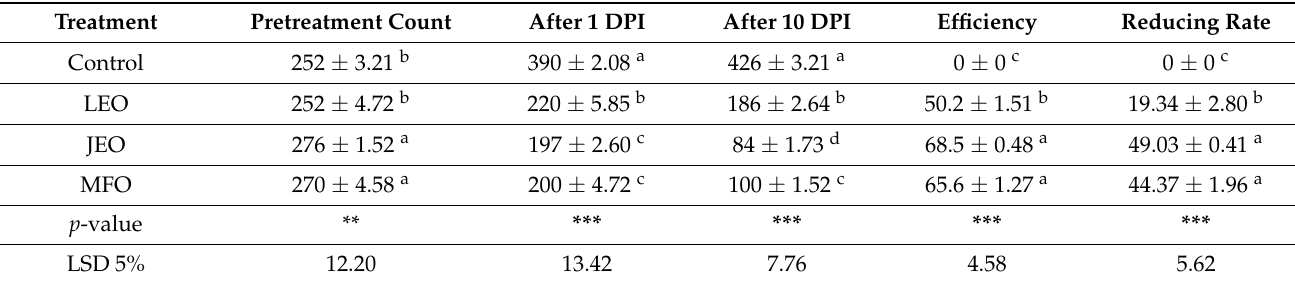
Table 1. The effect of foliar application with jasmine and lavender essential oils or mustard fixed oil on the eggplant population’s number of TSSM and their efficiency potential and reduction